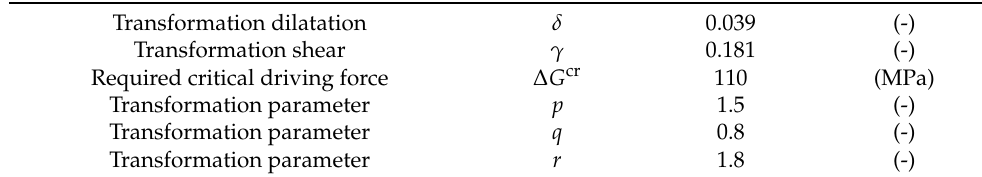
Table 2. Data for transformation of retained austenite.